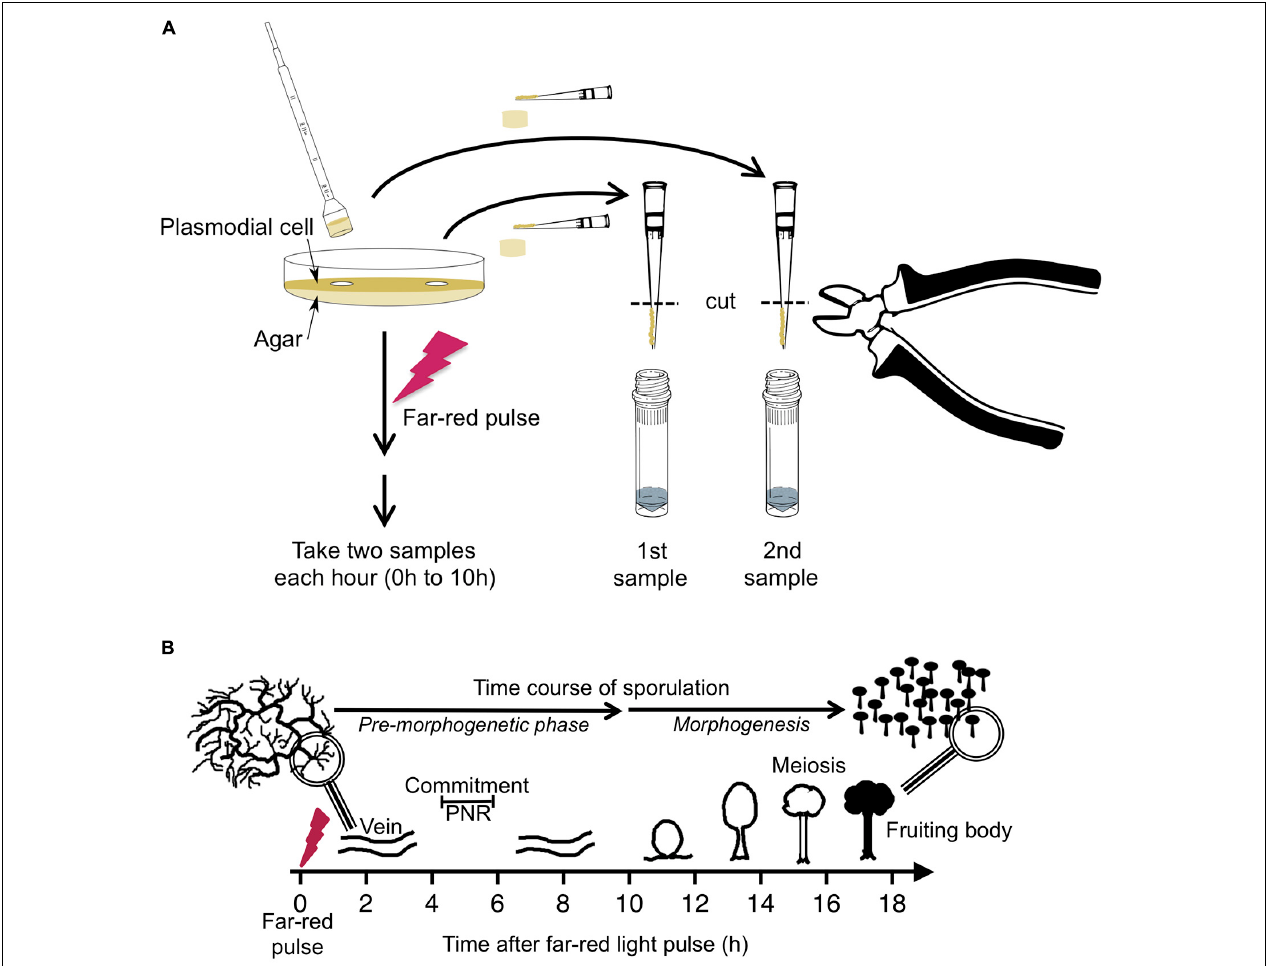
FIGURE 1 | Experimental protocol for taking time series by repeated sampling of individual plasmodial cells and time course of light-induced sporulation. (A) Each Petri dish contained one individual plasmodial cell supported by an agar substratum. Before and at 1-h time intervals after stimulation of the cell with a pulse of far-red light, samples were taken in duplicate by picking an agar plug at arbitrarily chosen but distant positions on the plate. The cell mass was scraped off from the agar plug with a pipet tip and transferred into a vial containing glass beads and liquid nitrogen. After purification of RNA, the gene expression pattern was estimated twice in each sample, each with two independent multiplex RT-PCR reactions (see section “Materials and Methods” for details). For dark controls, the far-red light stimulus was omitted. (B) Time frame of light-induced sporulation of a plasmodial cell. At about four to 6 h after stimulation with a pulse of far-red light, the cell is irreversibly committed to sporulation by crossing the point of no return (PNR) while there is no obvious change in the plasmodial morphology. Morphogenesis then starts at about 11 h after the stimulus by the formation of nodules that subsequently culminate to form the fruiting bodies. Panel B was taken from Glöckner and Marwan